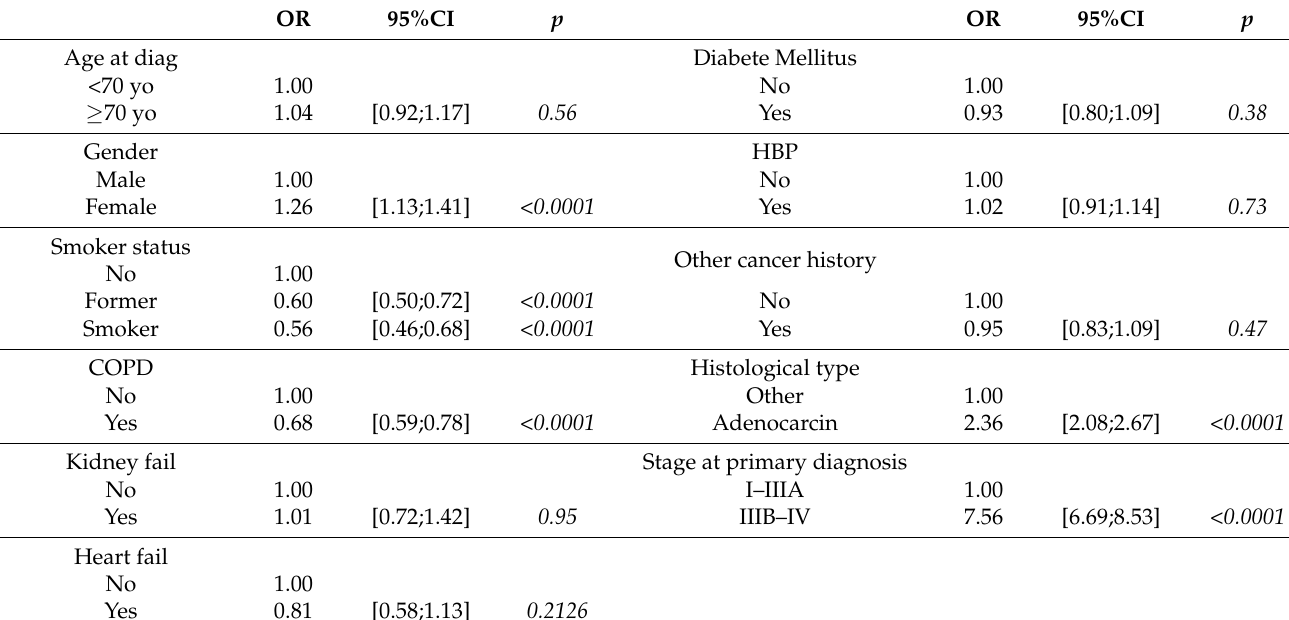
Table 3. Factors associated with biomarker testing in multivariable